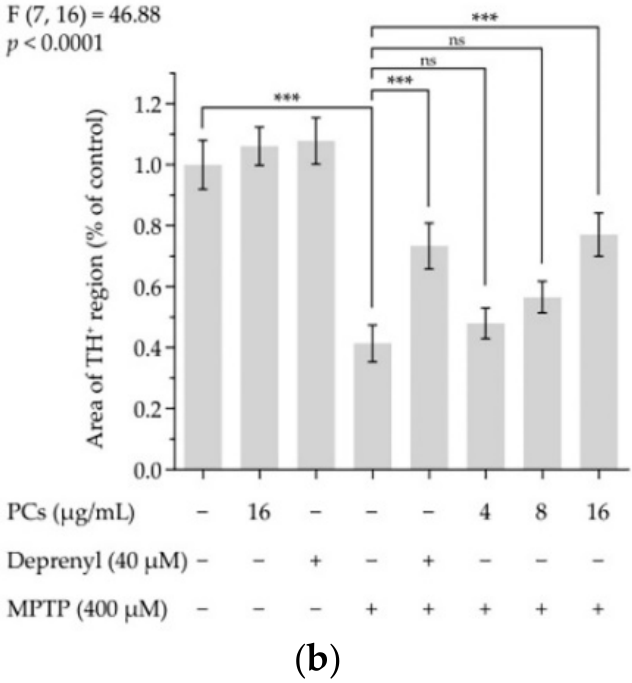
Figure 6. Effects of PCs on MPTP-induced dopaminergic neuron injury in zebrafish. ( a ) Represen- tative pictures of the dopaminergic neurons in the brains of zebrafish; ( b ) number of TH + neurons was measured by ImageJ. F and p values of the one-way analysis of variance are presented above the chart. The results of Tukey’s post hoc test are presented for selected comparisons on the chart: ns, p > 0.05; ***, p < 0.001; the error bars are SD.